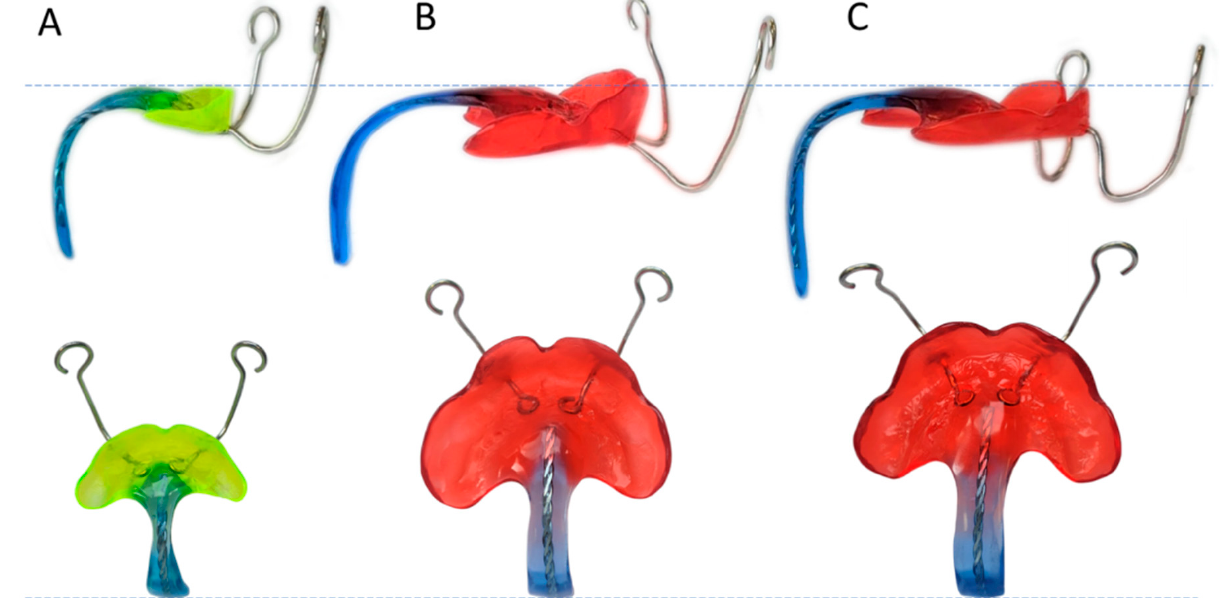
Figure 17. Three TPPs from different patient scenarios (Case A–C, see Table 2). Images are to scale and thus, show the real-life dimensional differences between the different TPPs.